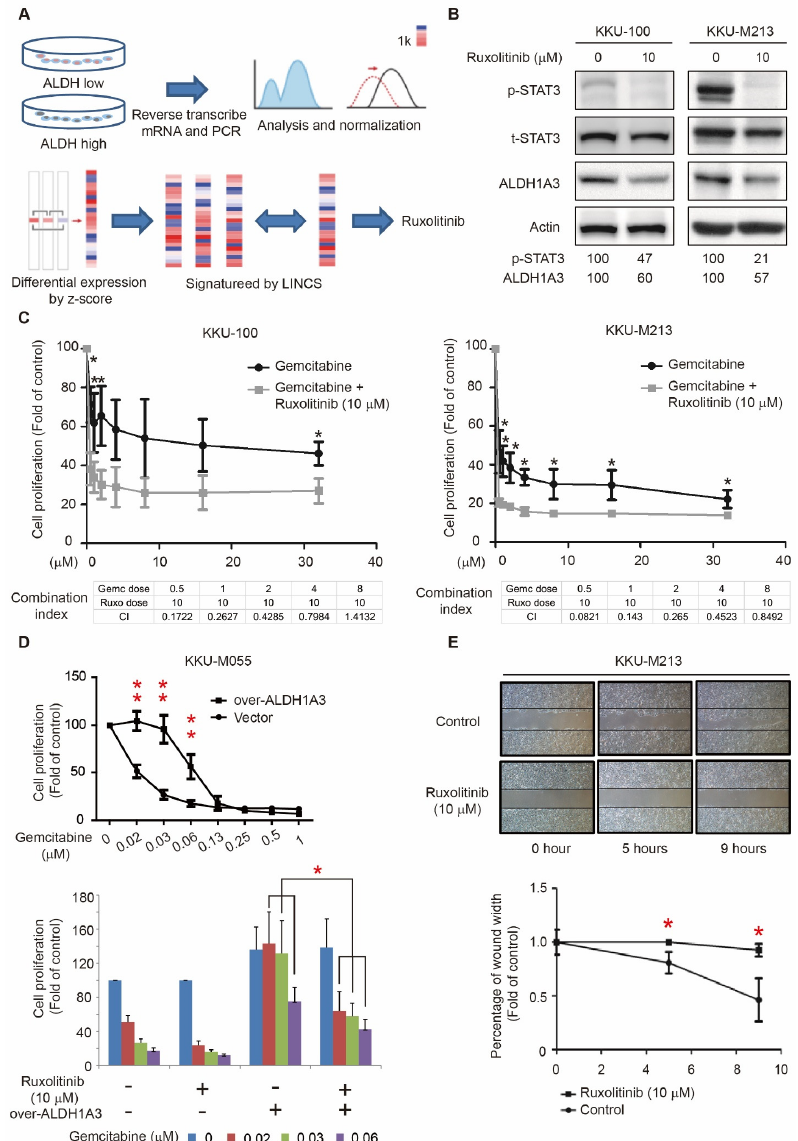
Figure 2. Ruxolitinib had a synergistic effect with gemcitabine and inhibited cholangiocarcinoma cell migration. ( A ) The inhibitors were identified as potential drugs. ( B ) Total lysates (20 µ g) from the KKU-100 and KKU-M213 cells were subjected to Western blotting analyses using primary antibodies against ALDH1A3, STAT3, and p-STAT3 as probes. β -actin signals were used as loading controls. ( C ) The KKU-100 (left, upper) and KKU-M213 (right, upper) cells were seeded onto 96-well plates and treated with gemcitabine alone or various concentrations of gemcitabine plus 10 µ M ruxolitinib for overnight incubation. At 48 h after treatment, cell viability was measured using an MTT assay and was normalized to the respective untreated cells. The combination index (CI) values of the interaction between gemcitabine plus ruxoli- tinib against KKU-100 (left, bottom) and KKU-M213 (right, bottom). Data shown are the averages of three independent experiments. * p < 0.05 compared with the untreated cells with the same treatments by Student’s t test. ( D ) The vector- and ALDH1A3-overexpressing KKU-M055 cells were seeded onto 96-well plates and treated with gemcitabine alone (upper) or various concentrations of gemcitabine plus 10 µ M ruxolitinib (bottom) for overnight incubation. At 48 h after treatment, cell viability was measured using an MTT assay and was normalized to the respective untreated cells. Data shown are the averages of three independent experiments. * p < 0.05, ** p < 0.01 compared with the vector cells with the same treatments by Student’s t test. ( E ) Cell migration abilities were analyzed using a wound-healing assay. Representative images reveal KKU-M213 cells treated with 10 µ M ruxolitinib compared with the control after 0, 5, and 9 h. The quantitative results shown in the bottom panels are the mean ± standard deviation of three independent experiments. * p < 0.05 compared with the respective vector cells by the Student’s t